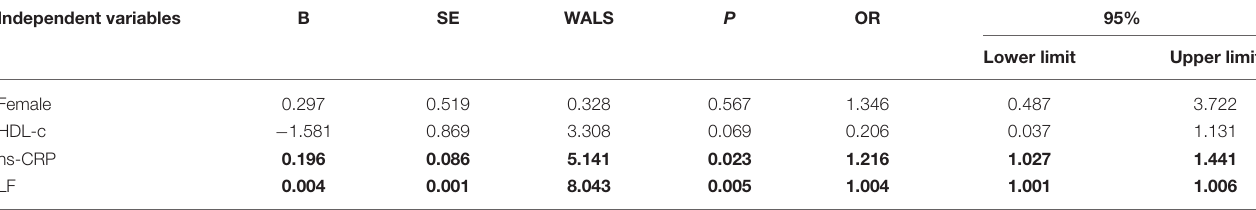
TABLE 2 | Independent predictors of cQFR of target vessel ≤ 0.8.